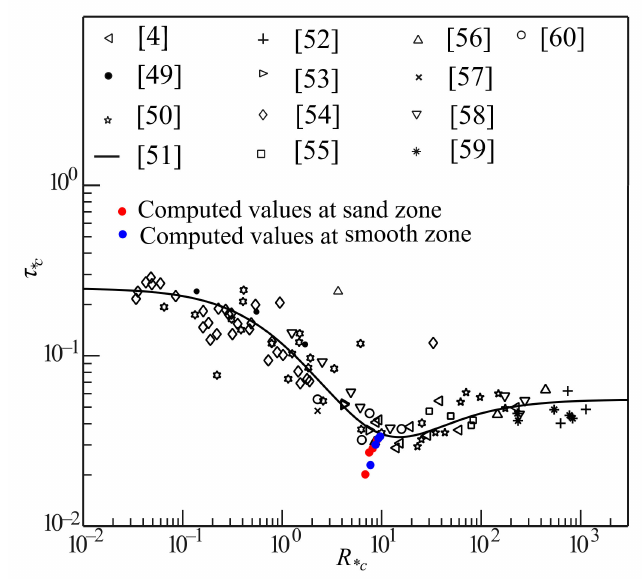
Figure 11. Extended Shields diagram